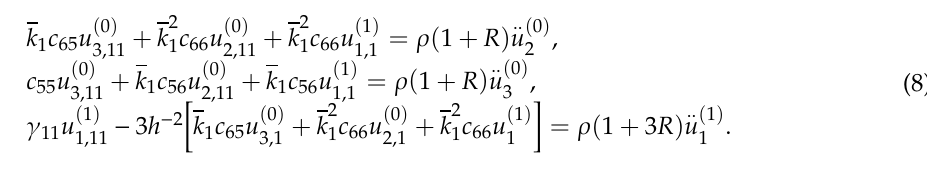
Figure 2. Dispersion relationships of (yxl) 90° LiTaO 3 plates for lateral field excitation.